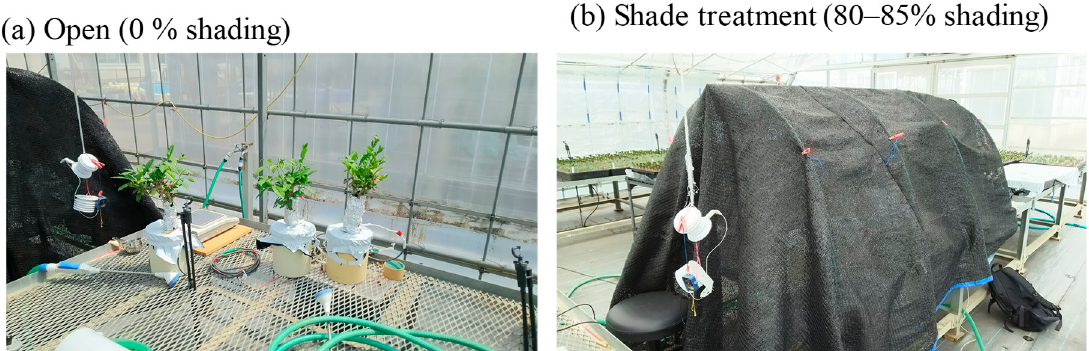
Figure 9. Shade treatments used during this study.